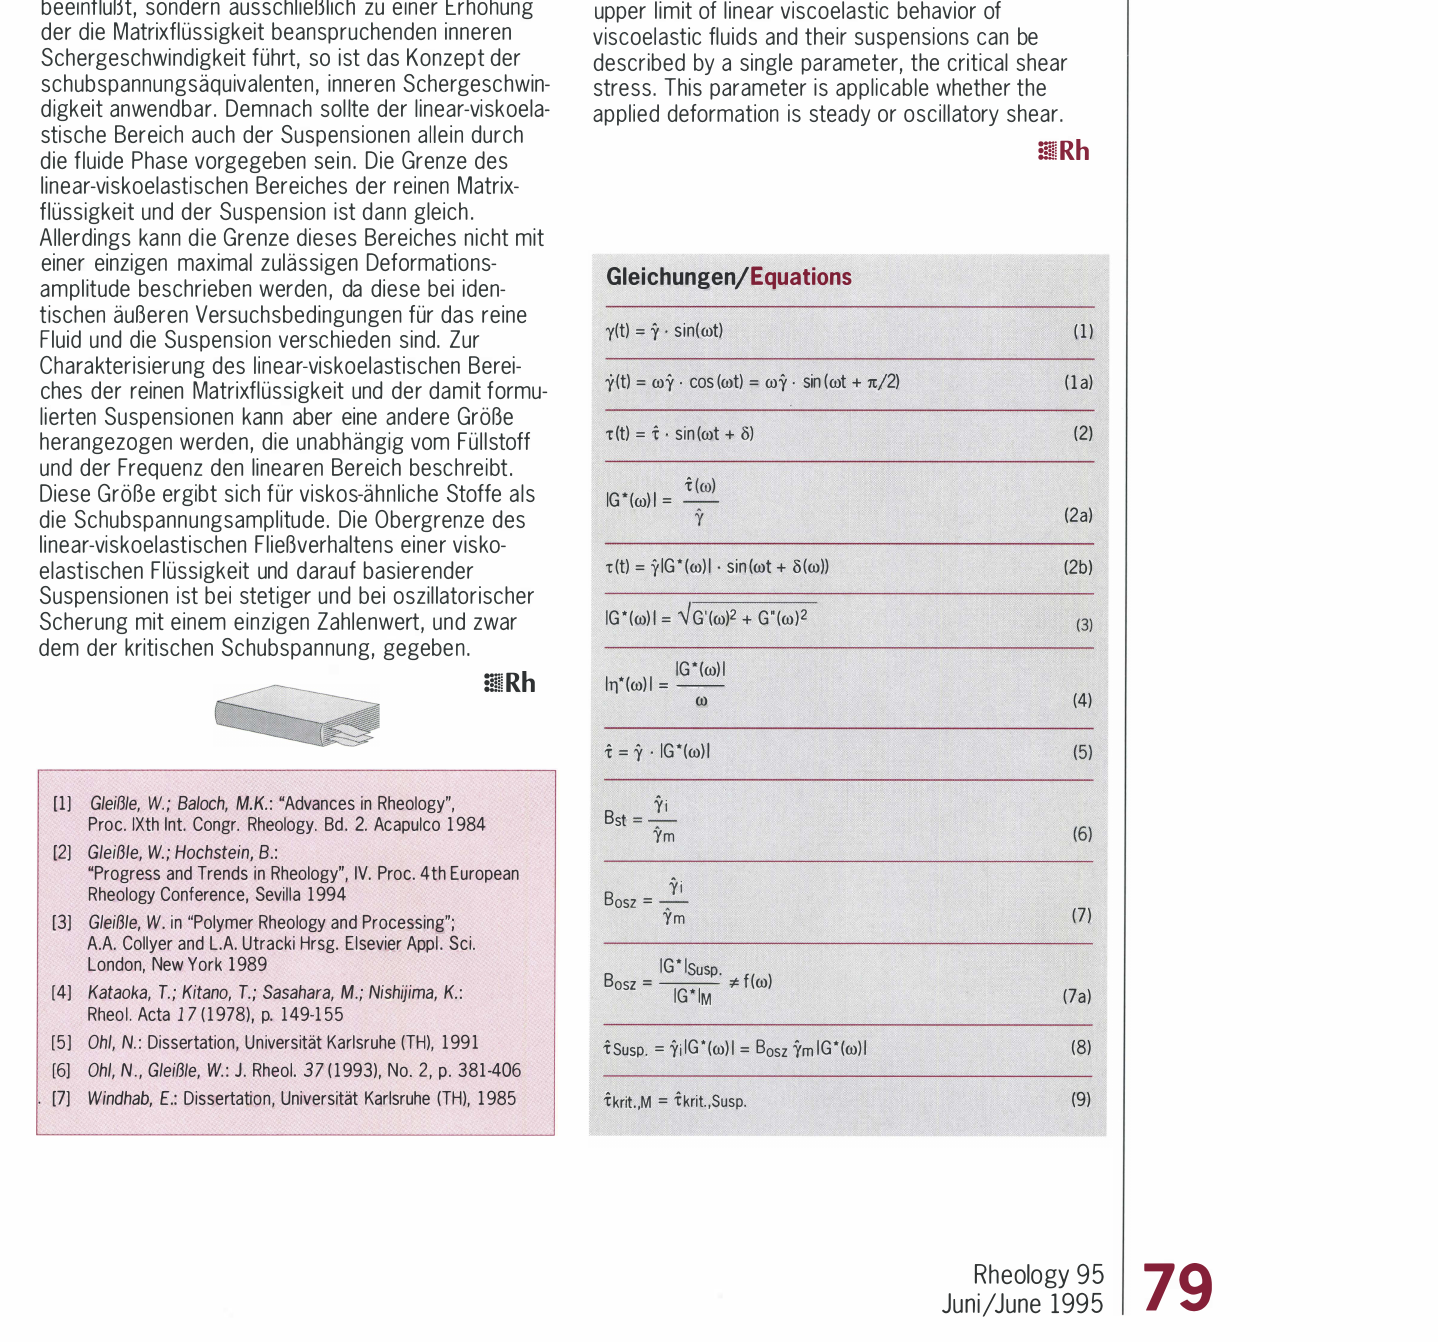
this parameter is the shear stress amplitude. The upper limit of linear viscoelastic behavior of viscoelastic fluids and their suspensions can be described by a single parameter, the critical shear stress. This parameter is applicable whether the applied deformation is steady or oscillatory shear.